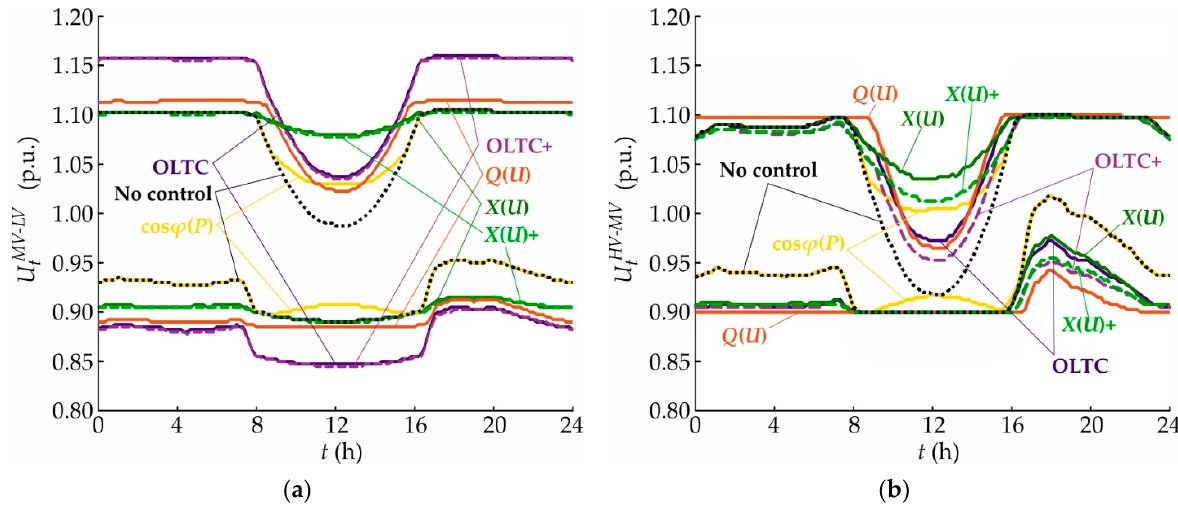
Figure 22. Voltage limits at different system boundaries for various control arrangements: ( a ) MV − LV boundary (rural LV_Link-Grid); ( b ) HV − MV boundary.